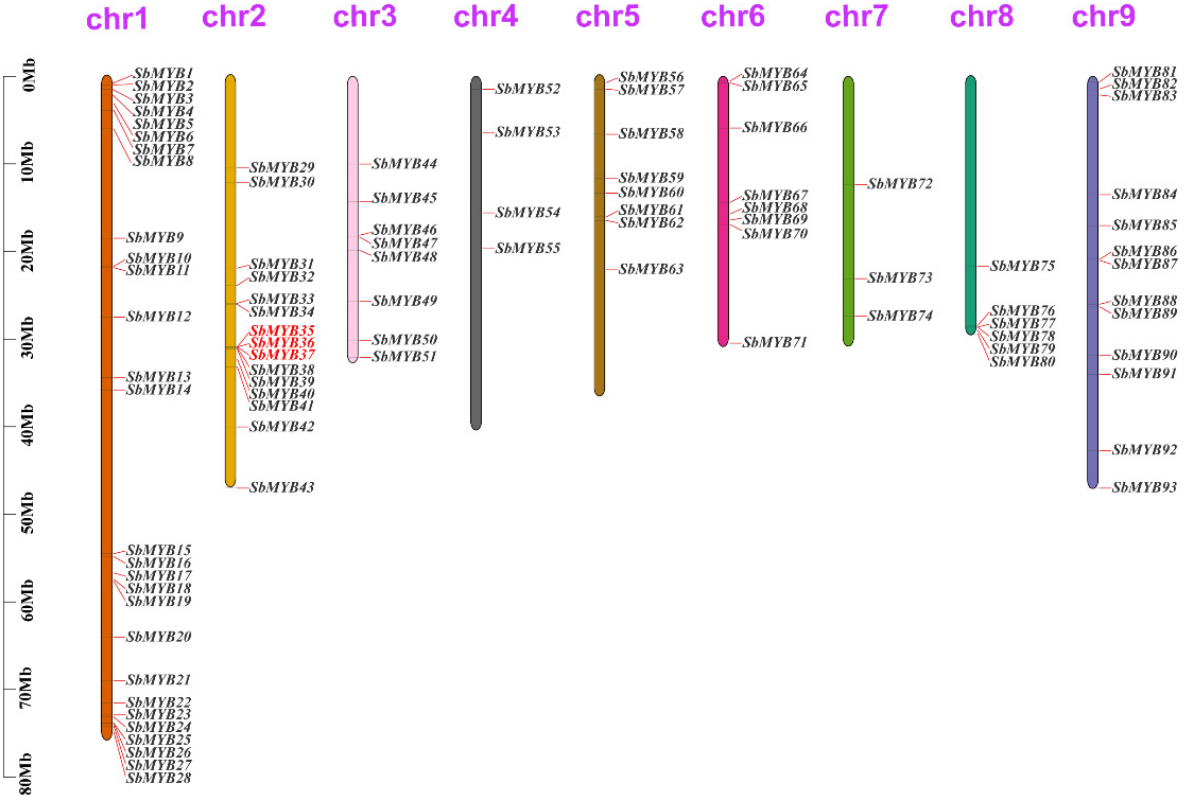
Figure 3. Chromosomal map of R2R3-SbMYB genes was generated for S. baicalensis . A total of 93 R2R3-SbMYB genes were located on nine different chromosomes, with the remaining two genes resided on the unassembled scaffold ( SbMYB94 and SbMYB95 ). Every chromosome has a number at the top and is scaled in megabases (Mb). Gene names that are highlighted in red on each chromosome indicate tandem duplications.